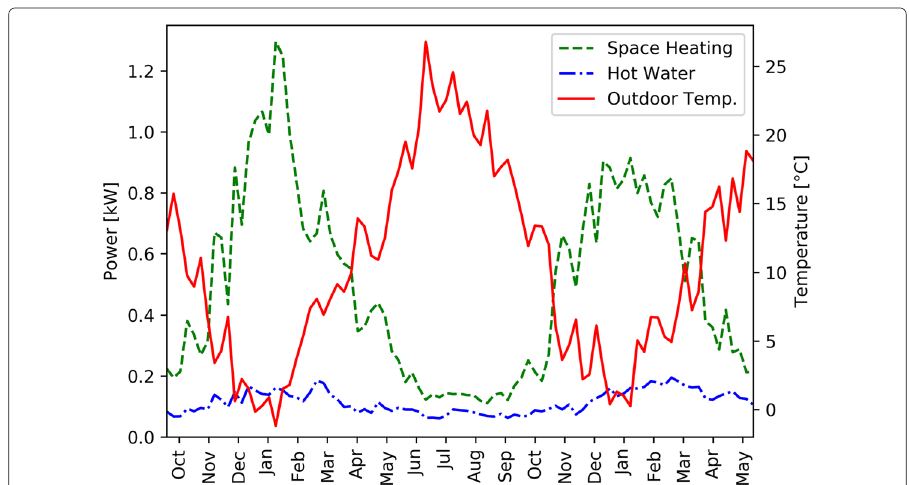
Fig. 5 Weekly average outdoor temperature in Sion and weekly average consumed power of both space heating and hot water appliances between October 2018 and May 2020